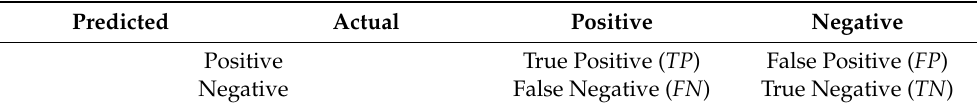
Table 5. Confusion